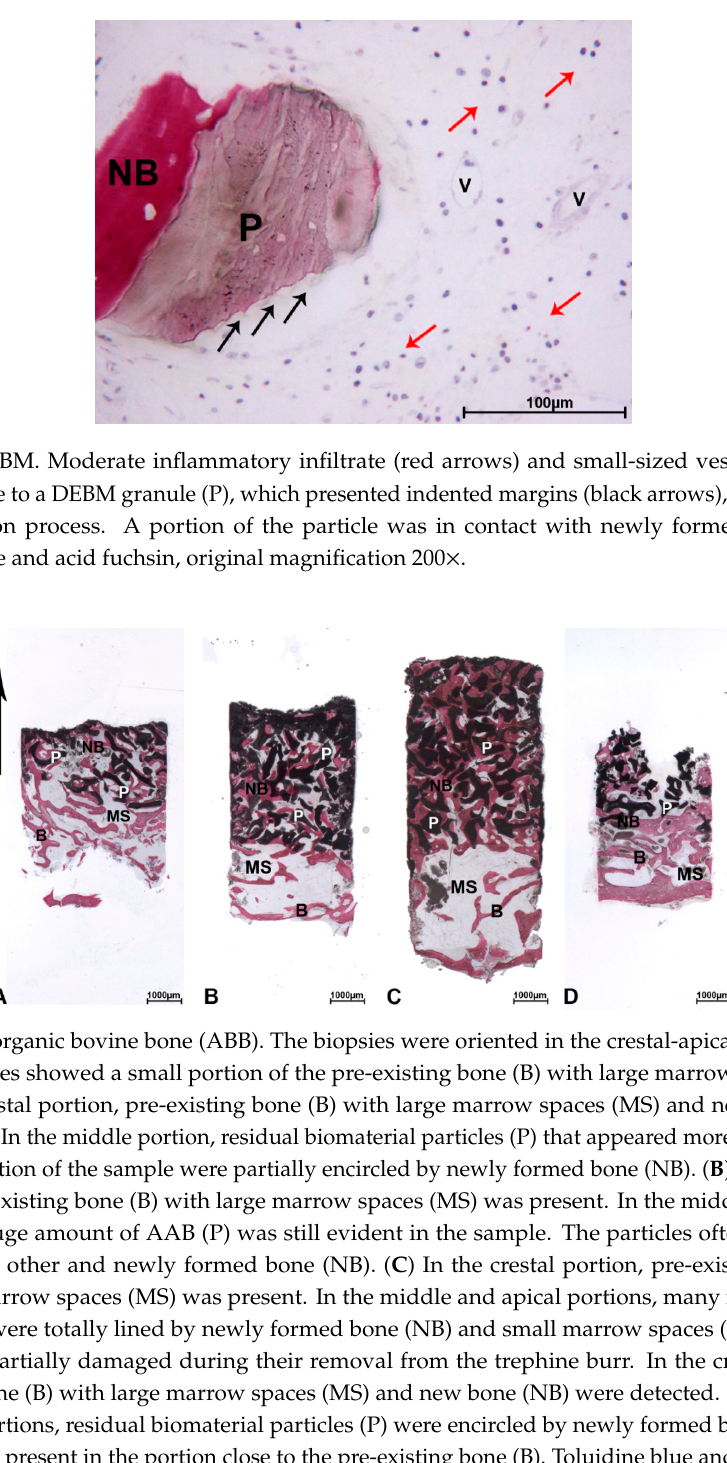
Figure 4. DEBM . Moderate inflammatory infiltrate (red arrows) and small-sized vessels (V) were observed close to a DEBM granule (P), which presented indented margins (black arrows), probably due to a resorption process. A portion of the particle was in contact with newly formed bone (NB). Toluidine blue and acid fuchsin, original magnification 200×.